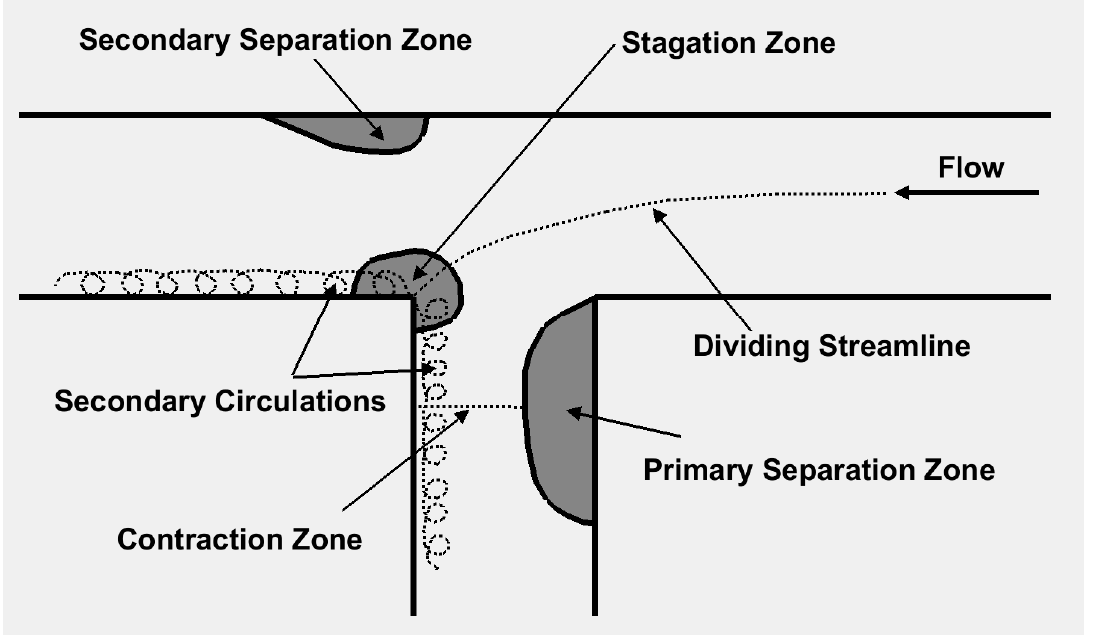
Figure 1. Schematic illustrating major flow structures at a typical flow juncture according to [1].